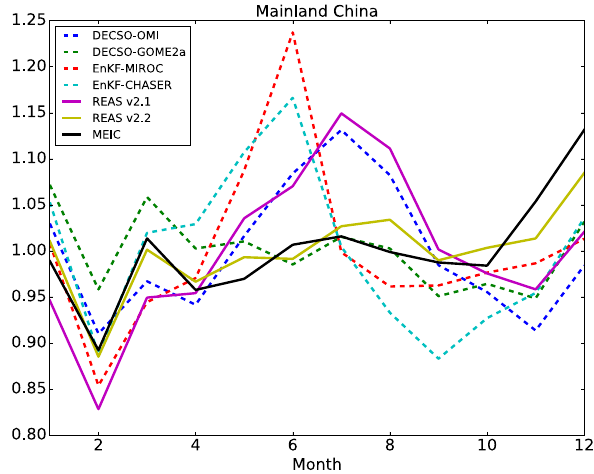
Figure 6. Monthly variability in NO x emissions over mainland China in the selected domain (see Fig.